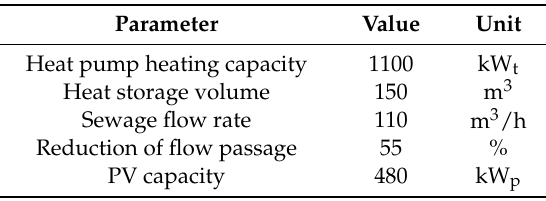
Table 2. Final configuration of the